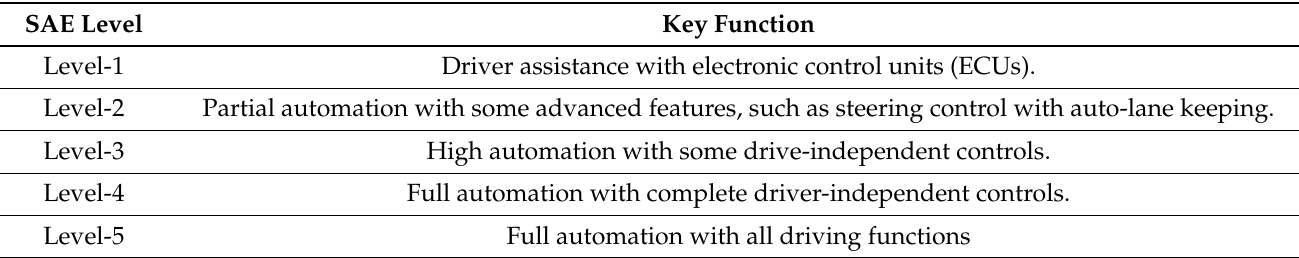
Table 1. Society of Automotive Engineers (SAE) Levels of Autonomous Vehicles. Key